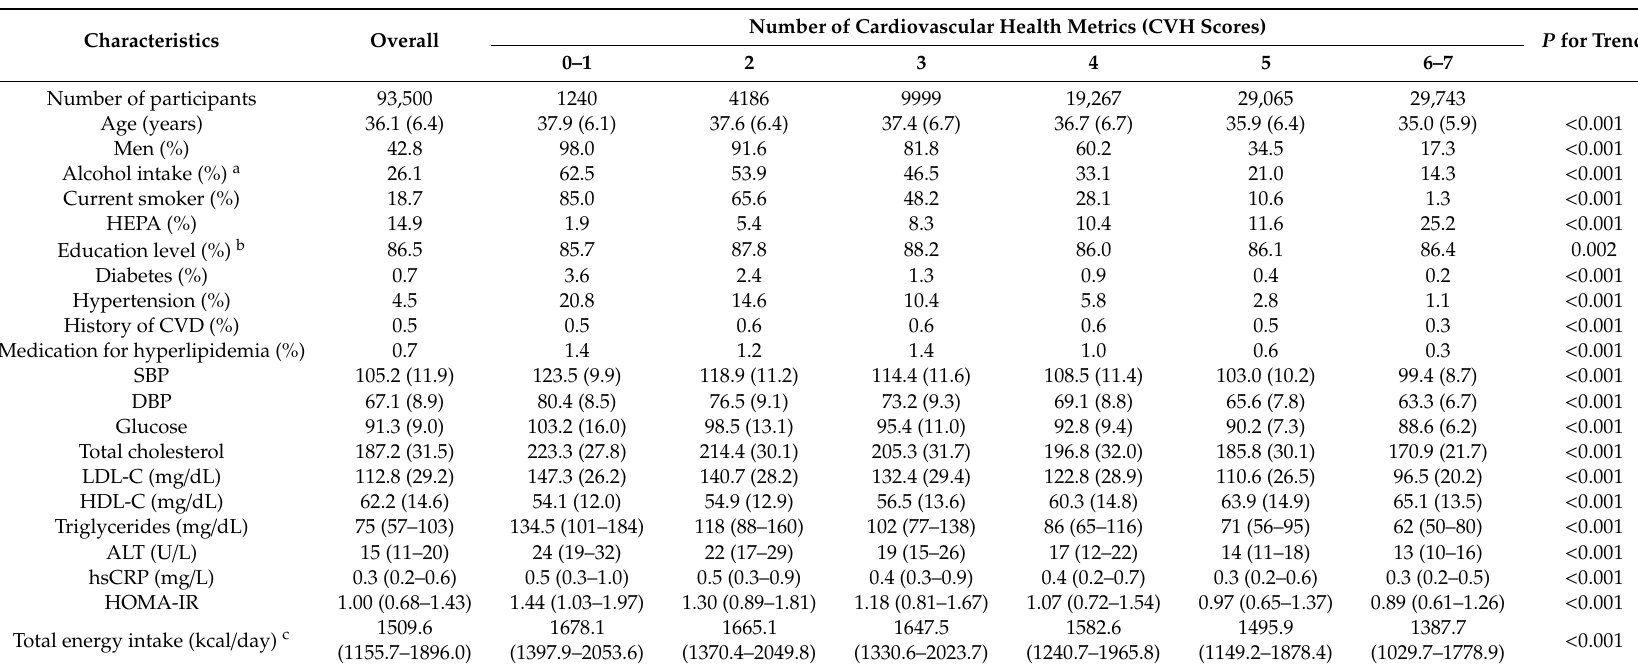
Table 1. Baseline characteristics by cardiovascular health metrics (CVH) scores among 93,500 participants without nonalcoholic fatty liver disease (NAFLD).